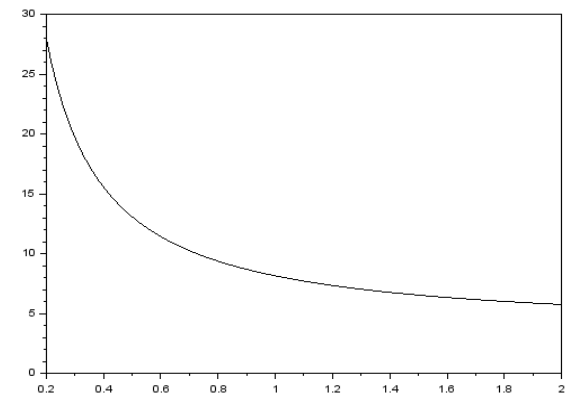
Figure 3. The shape of c a (T) as given by (26) under the condition